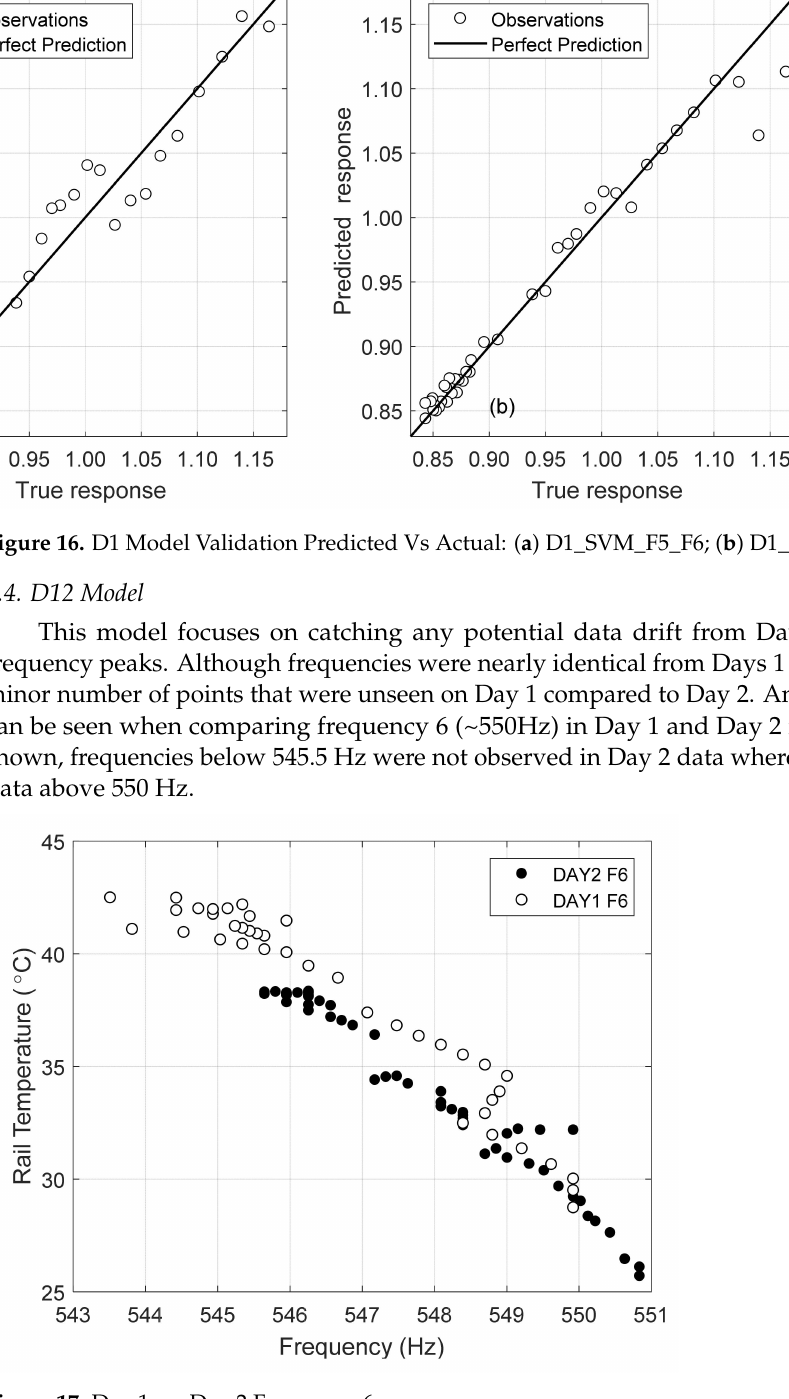
Figure 17. Day 1 vs. Day 2 Frequency